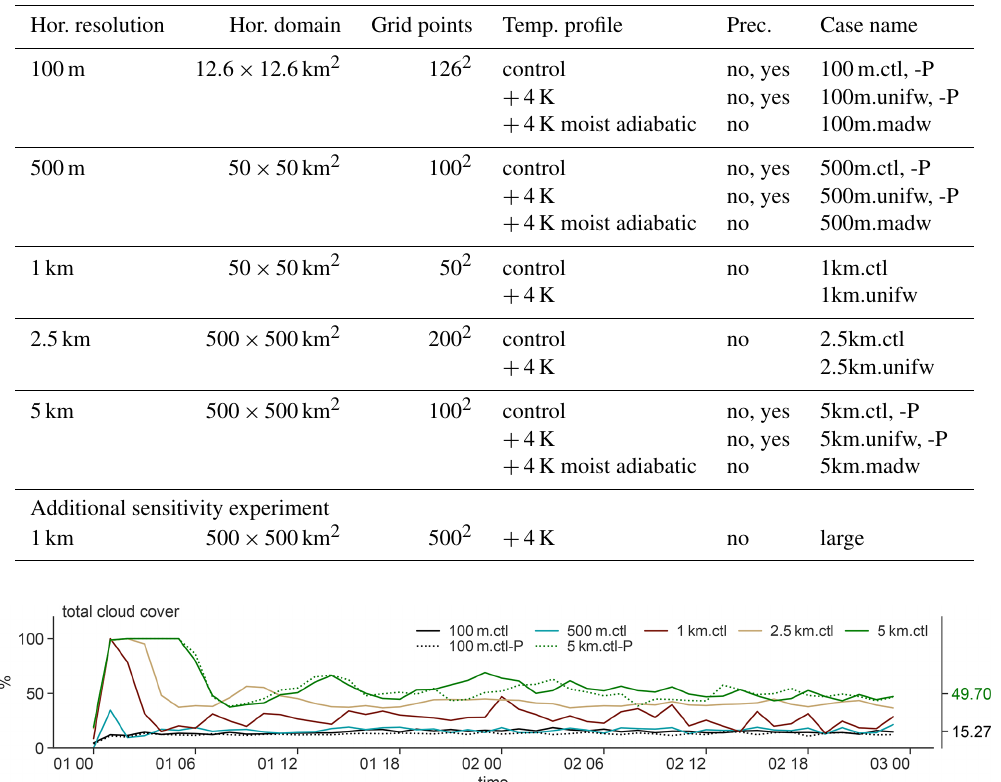
Figure 2. Temporal evolution of total cloud cover in ctl at 100m, 500m, 1km, 2.5km and 5km resolution (solid lines) and ctl-P at 100m and 5km resolution (dotted lines). Ordinates on the right axis display the second-day domain-averaged total cloud cover for 100m.ctl and 5km.ctl (see Tables 2 and 3 for more